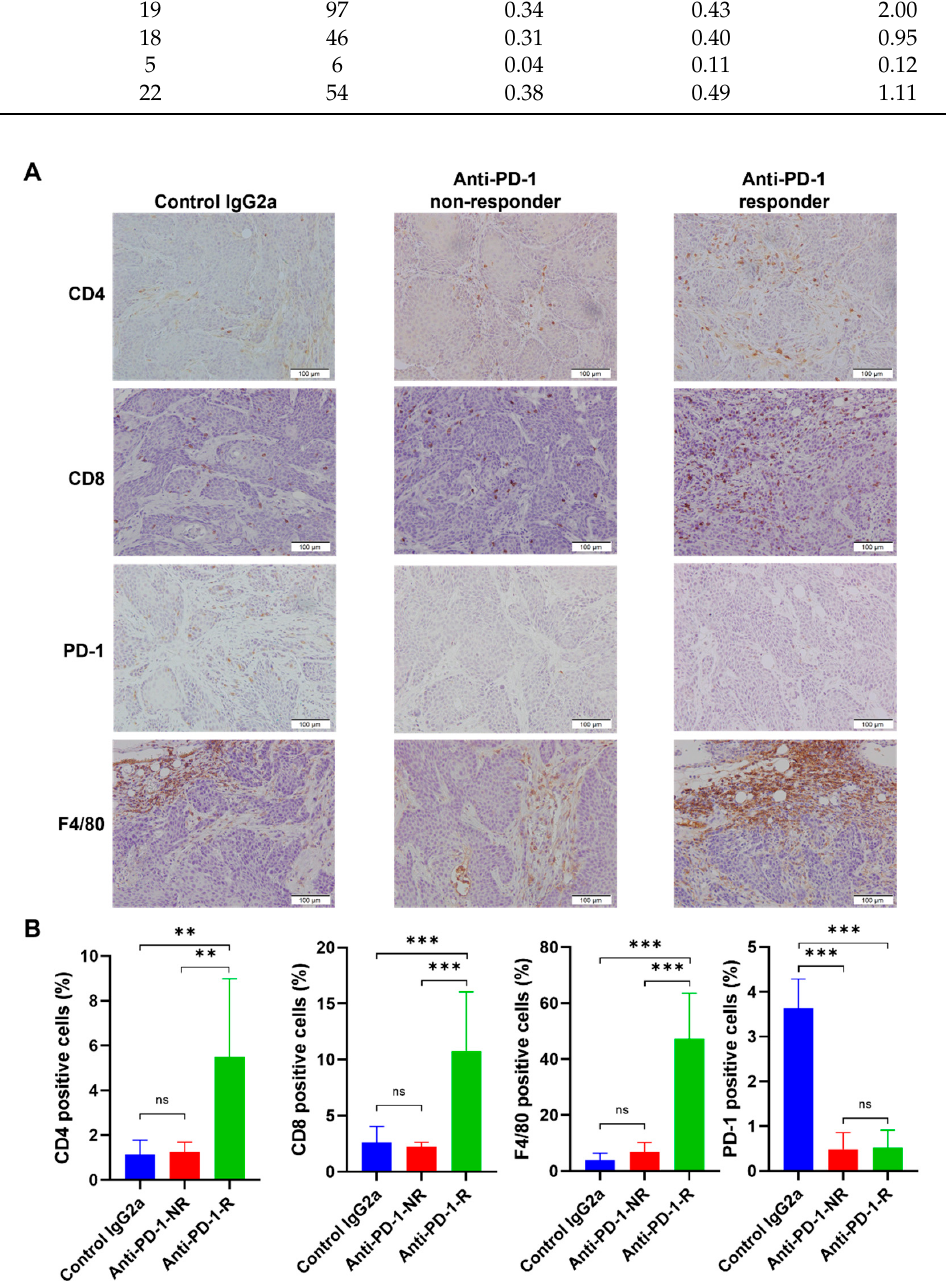
Figure 5. IHC staining of CD4, CD8, PD-1, and F4/80 in control and anti-PD-1 treated TKO tumors. ( A ) Representative IHC staining (CD4, CD8, PD-1, and F4/80) is shown in control IgG2a, anti-PD-1 (non-responders), and anti-PD-1 (responders). ( B ) The quantification of the percentages of CD4, CD8, PD-1, and F4/80 positive cells in the TKO tumors treated with control IgG2a, anti-PD-1 (non- responders), and anti-PD-1 (responders). p -value, ANOVA with Tukey's multiple comparisons test, p < 0.01 (**), and p < 0.001 (***).